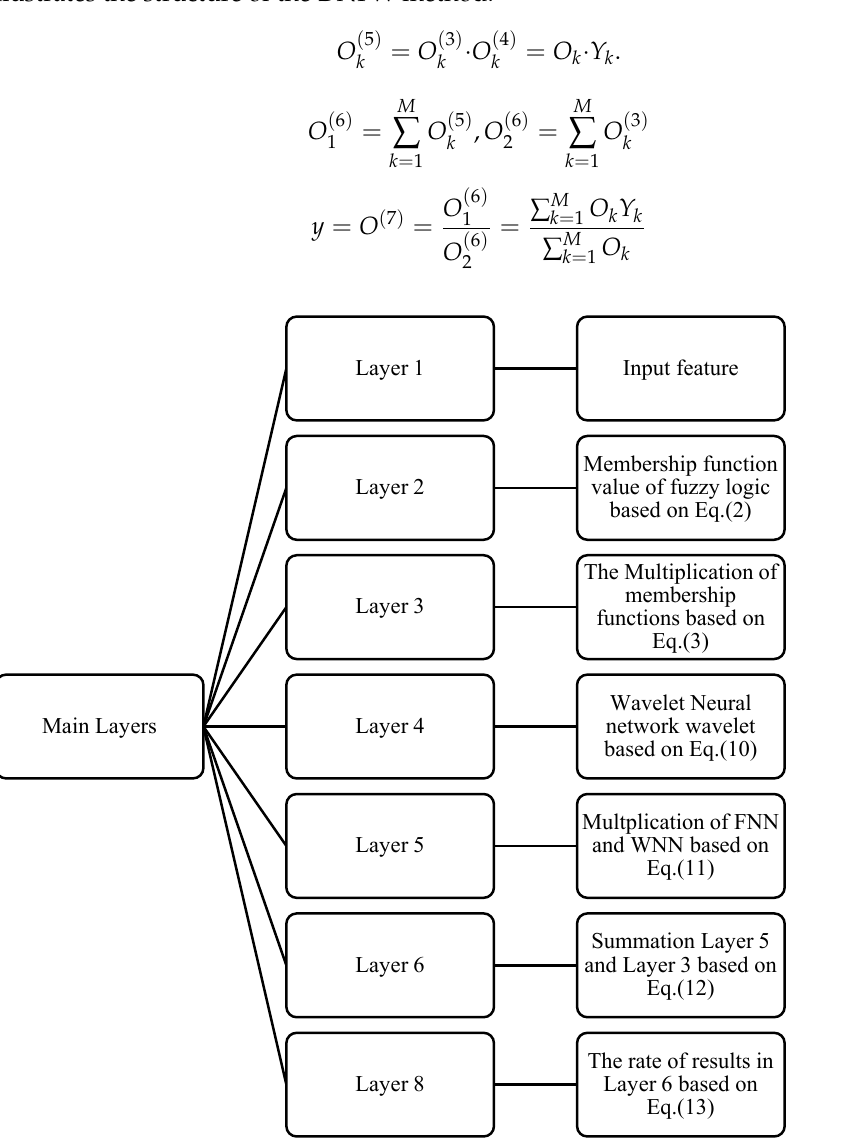
Figure 2. The DNFW method’s architecture.